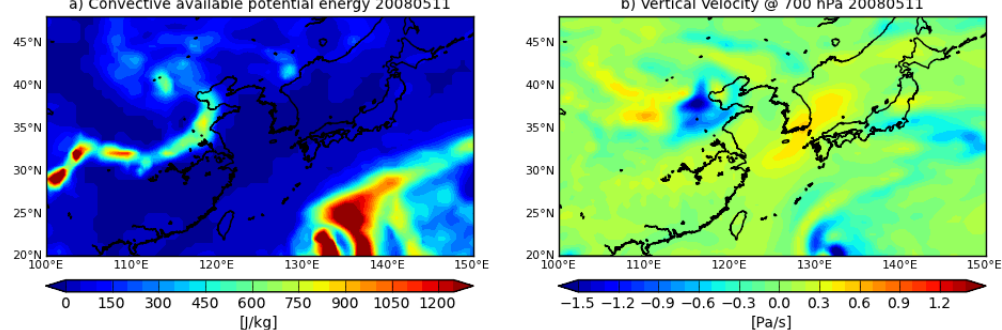
Figure 8. Convective available potential energy (a) and vertical velocity at 700hPa (b) from ERA-Interim reanalysis.